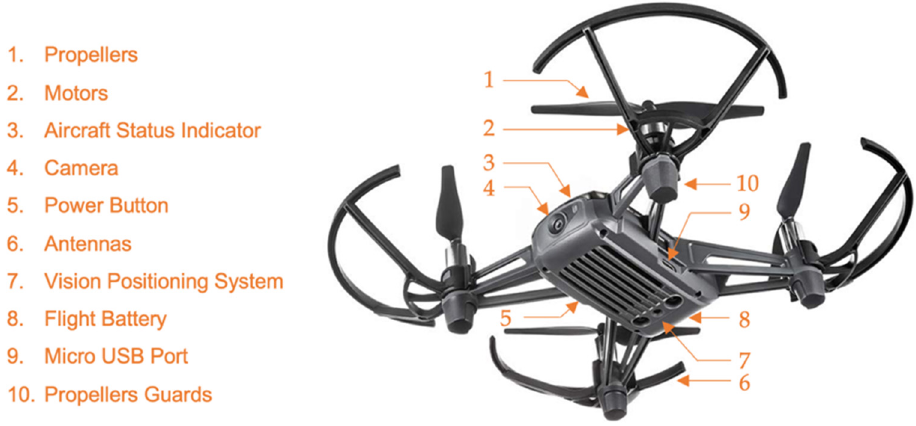
Figure 3. Basic components of the Tello